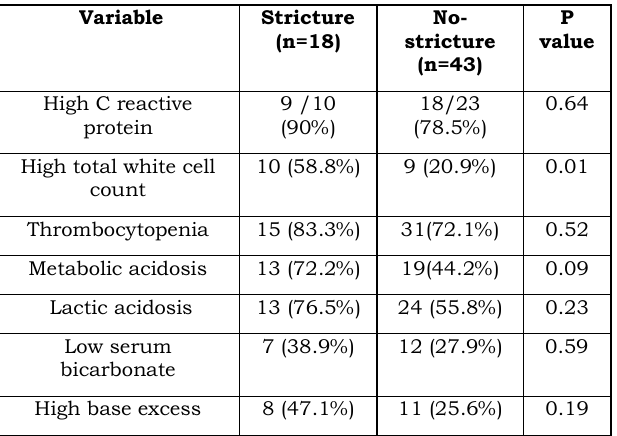
Table 2: Haematological